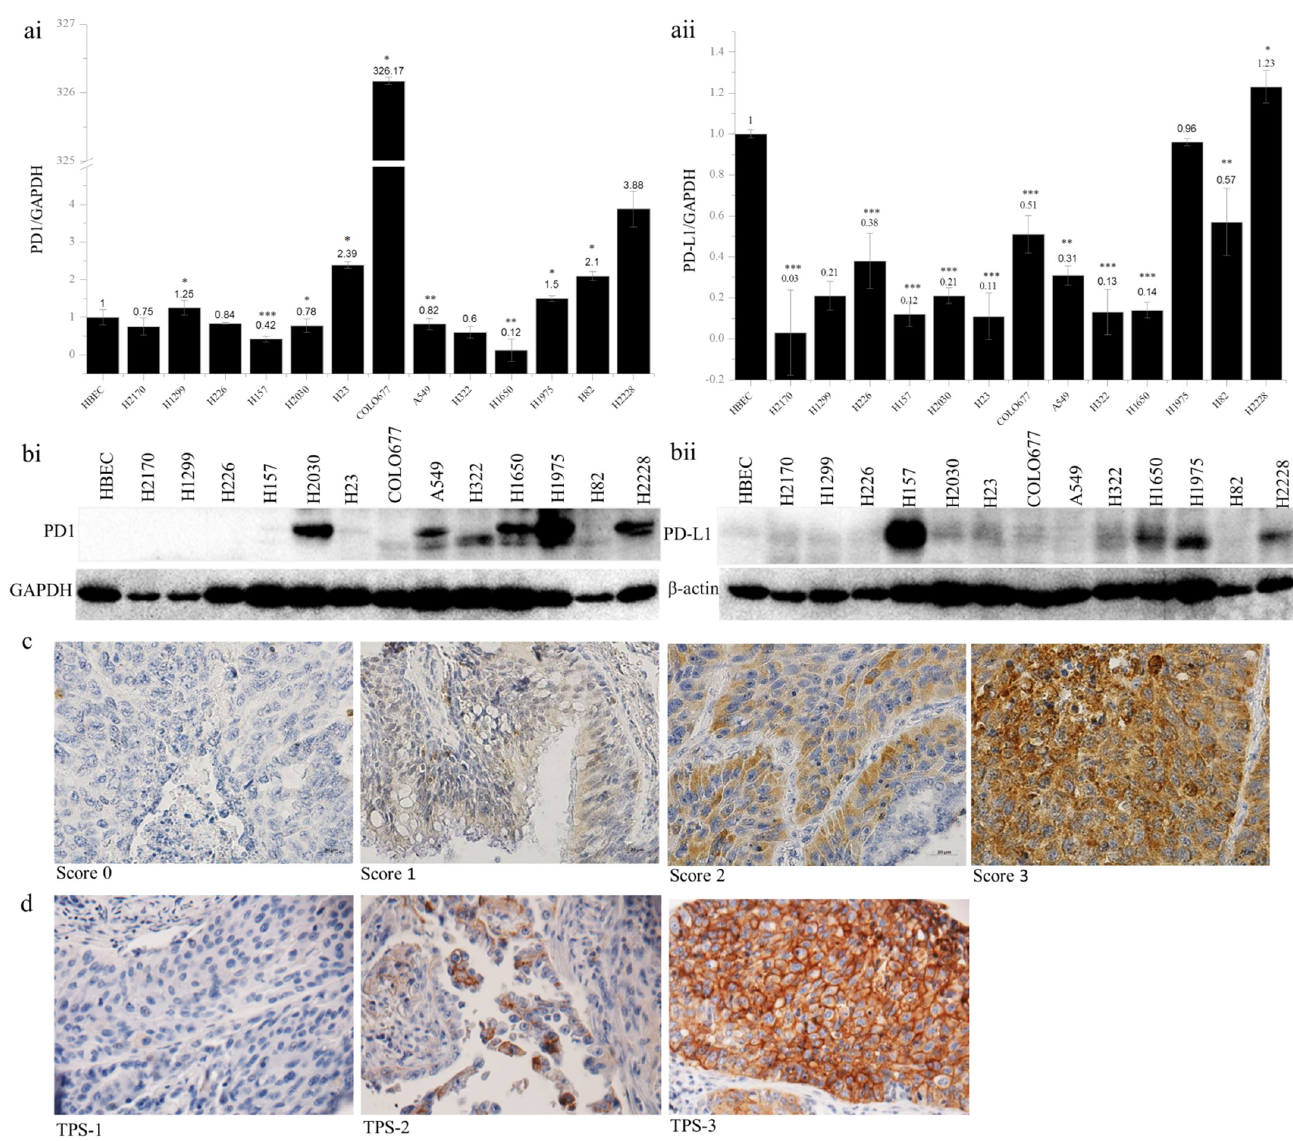
Figure 1. PD1 and PD-L1 expression in human lung cancer cell lines and primary lung tumors. PD1 ( ai ) and PD-L1 ( aii ) mRNA expression analyzed by quantitative real-time RT-PCR. The PD1 and PD-L1 mRNA expression was normalized to the expression level of GAPDH as an internal control, which in normal human bronchial epithelial cells (HBEC) was defined as 1.0; * p < 0.05, ** p < 0.01, *** p < 0.001 when analyzed using Student’s t -test. PD1 ( bi ) and PD-L1 ( bii ) protein expression analyzed by Western blotting. β -actin was used as a loading control. Representative images from immunohistochemical staining of PD1 ( c ) and PD-L1 ( d ) in primary lung tumor samples. TPS, tumor proportion score. Magnification, 400×.